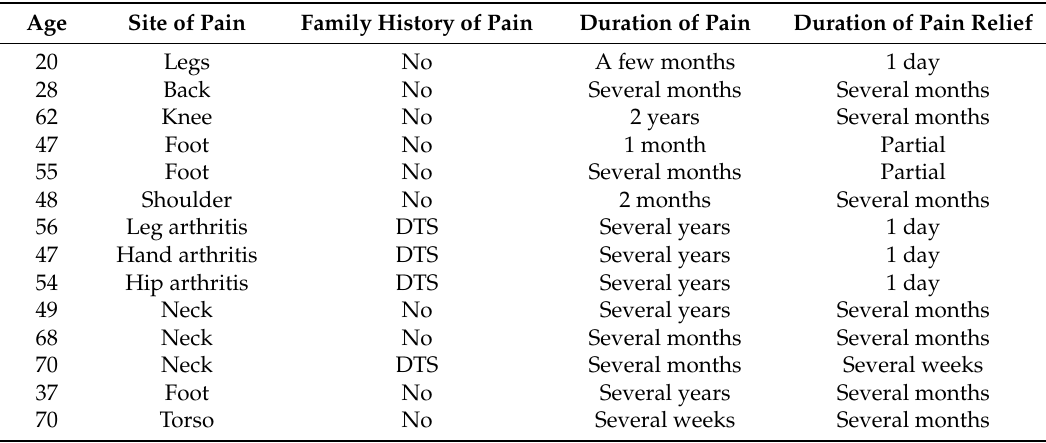
Table 1. Patient data summary. All patients reported initial pain of 6–10. Most had decreased pain